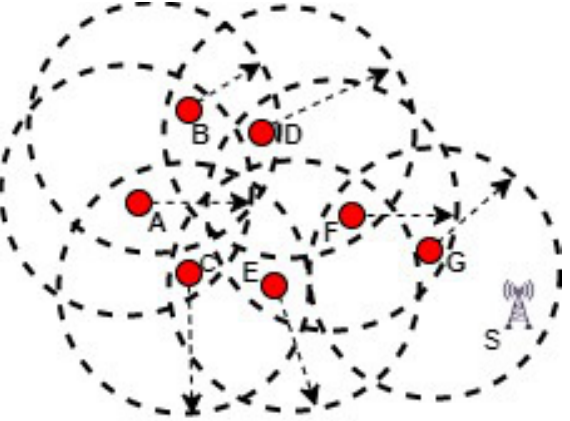
Figure 1. Red dots represent vehicles, the black triangle S denotes the infrastructure, the arrows are the transmission range and